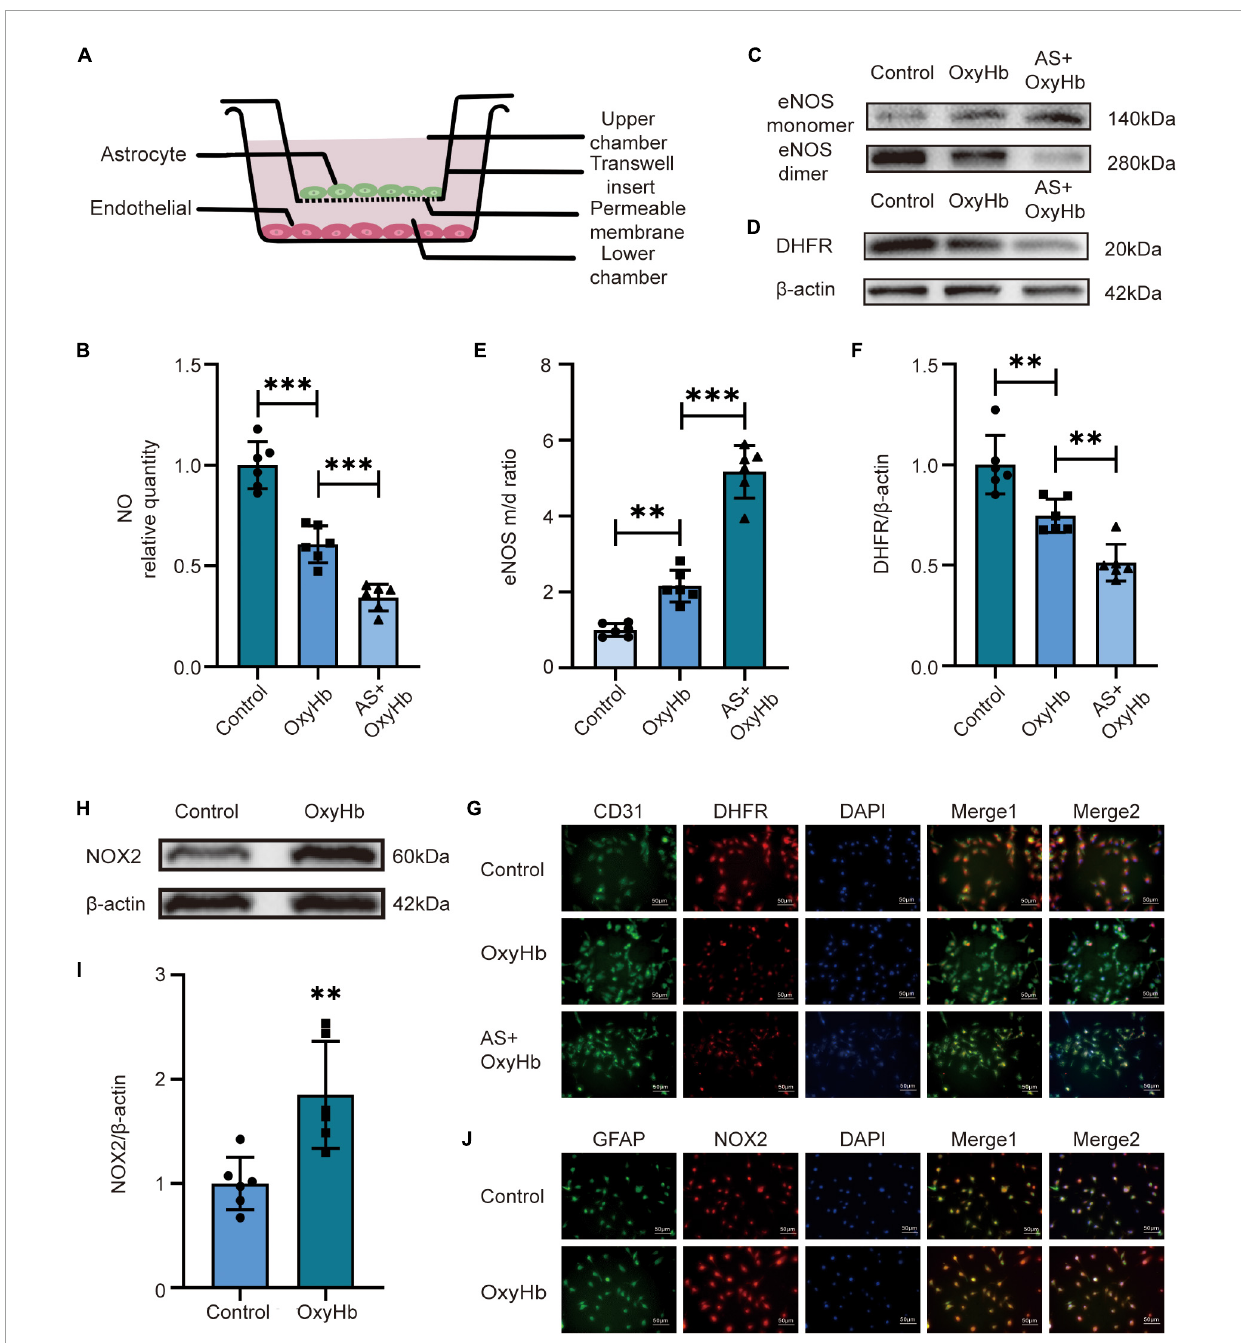
FIGURE2 Alterations in NO release, NOX2 and DHFR expression, and eNOS monomer/dimer ratio in endothelial cells after SAH. (A) Diagram of co-culture of HA and hCMEC/D3 cells. (B) NO released by endothelial cells among different experimental groups. Data are shown as mean ± SD ( n = 6 each group, ∗∗∗ p < 0.001, ns: no statistically significant difference). (C,D) Representative Western blot images and quantitative analysis of eNOS monomer and eNOS dimer expression by ImageJ. Data are shown as mean ± SD ( n = 6 each group, ∗∗ p < 0.01, ∗∗∗ p < 0.001). (E,F) Representative Western blot images and quantitative analysis of endothelial DHFR expression by ImageJ. Data are shown as mean ± SD ( n = 6 each group, ∗∗ p < 0.01). (H,I) Representative Western blot images and quantitative analysis of astrocytes NOX2 expression by ImageJ. Data are shown as mean ± SD ( n = 6 each group, ∗∗ p < 0.01). (G) Immunofluorescence images showed the co-localization of CD31 and DHFR. All scale bars, 50 µ m. (J) Immunofluorescence images showed GFAP and NOX2 colocalization. All scale bars, 50 µ m.